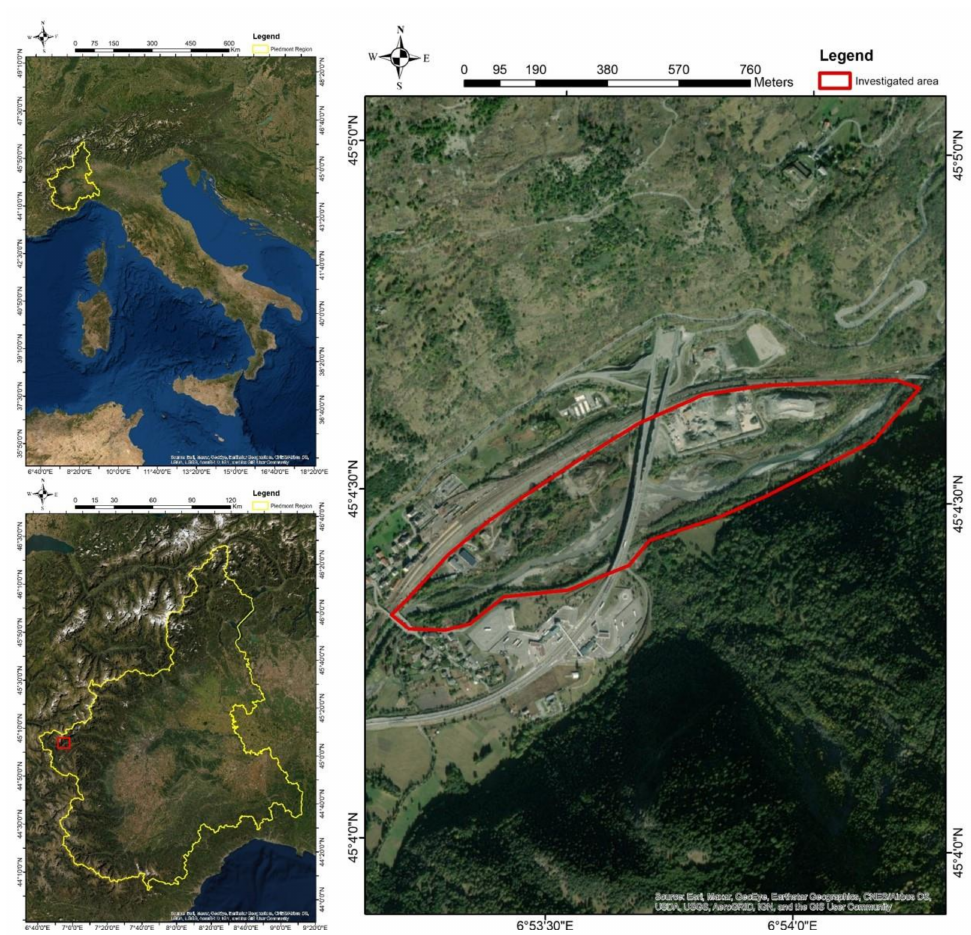
Figure 1. Geographical site of the covered area of the Dora Riparia river: Salbertrand